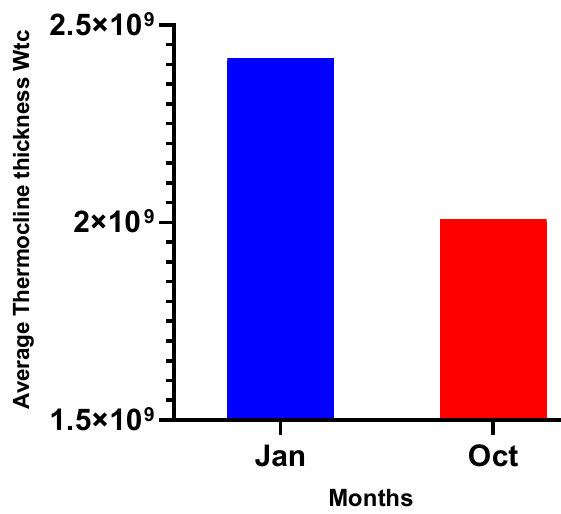
Figure 9. Average cumulative charge with month.